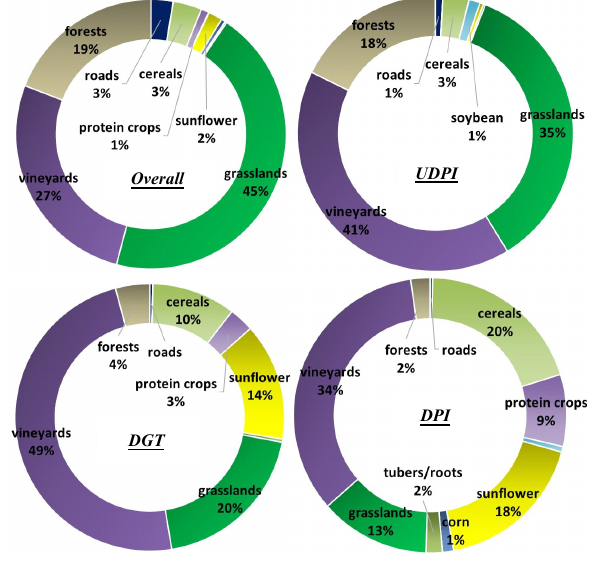
Figure 3. Land use distribution of plots by class (OSO)